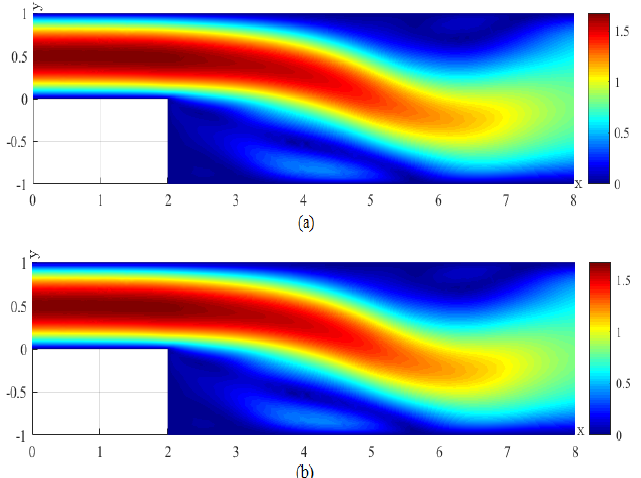
Figure 4. ( a ) The velocity magnitude for the CNMFE solution at t = 4. ( b ) The velocity magnitude for the RDRCNMFE solution at t = 4.